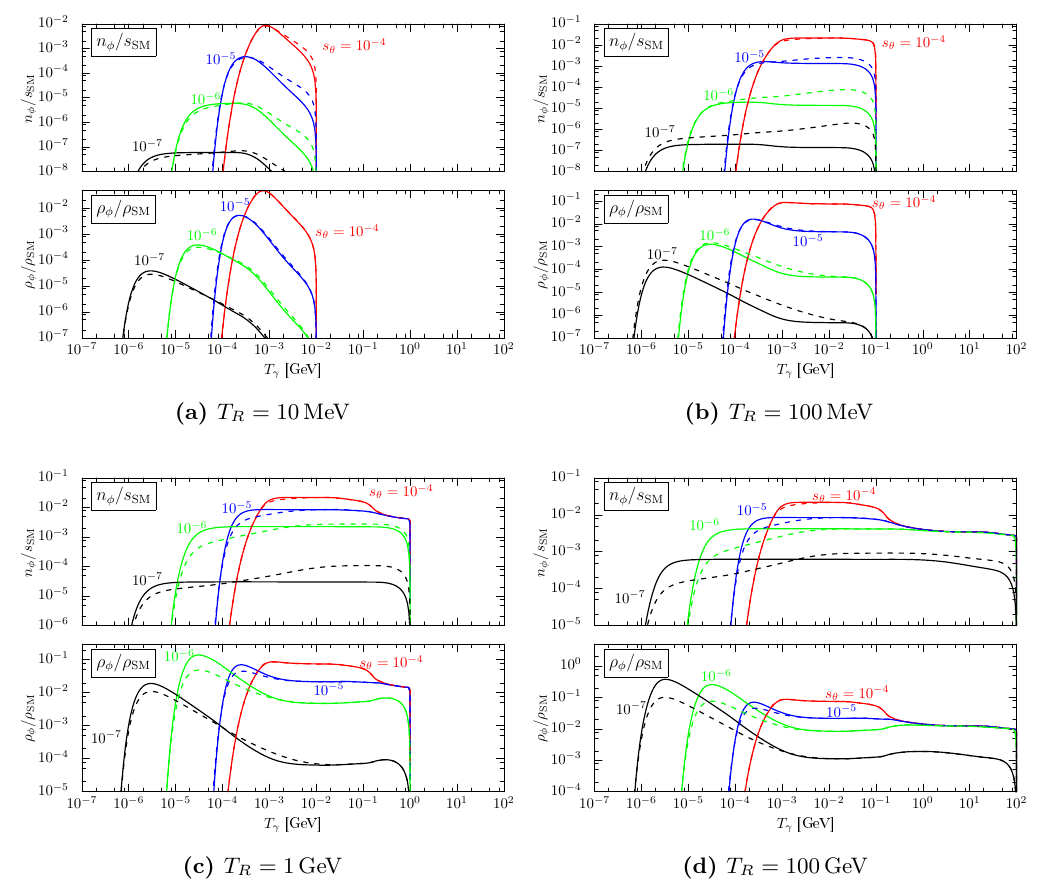
Figure 9. Time evolution of the number and the energy densities of the dark scalar with m φ = 2 MeV for the initial temperature T R = 10 MeV , 100 MeV , 1 GeV , 100 GeV . The dashed (solid) lines show the case of the self-thermalization (no